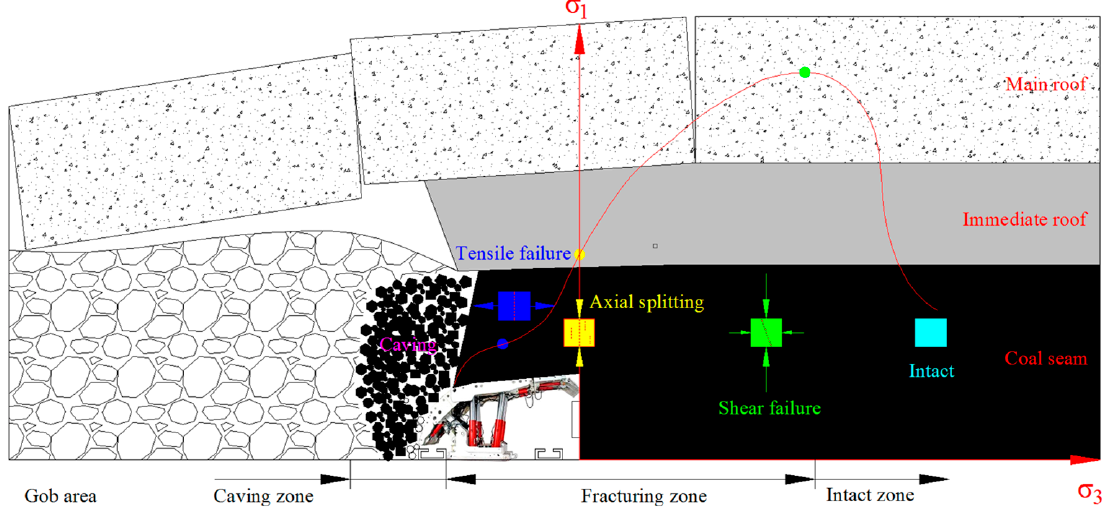
Figure 1. Layout of LTCC face.